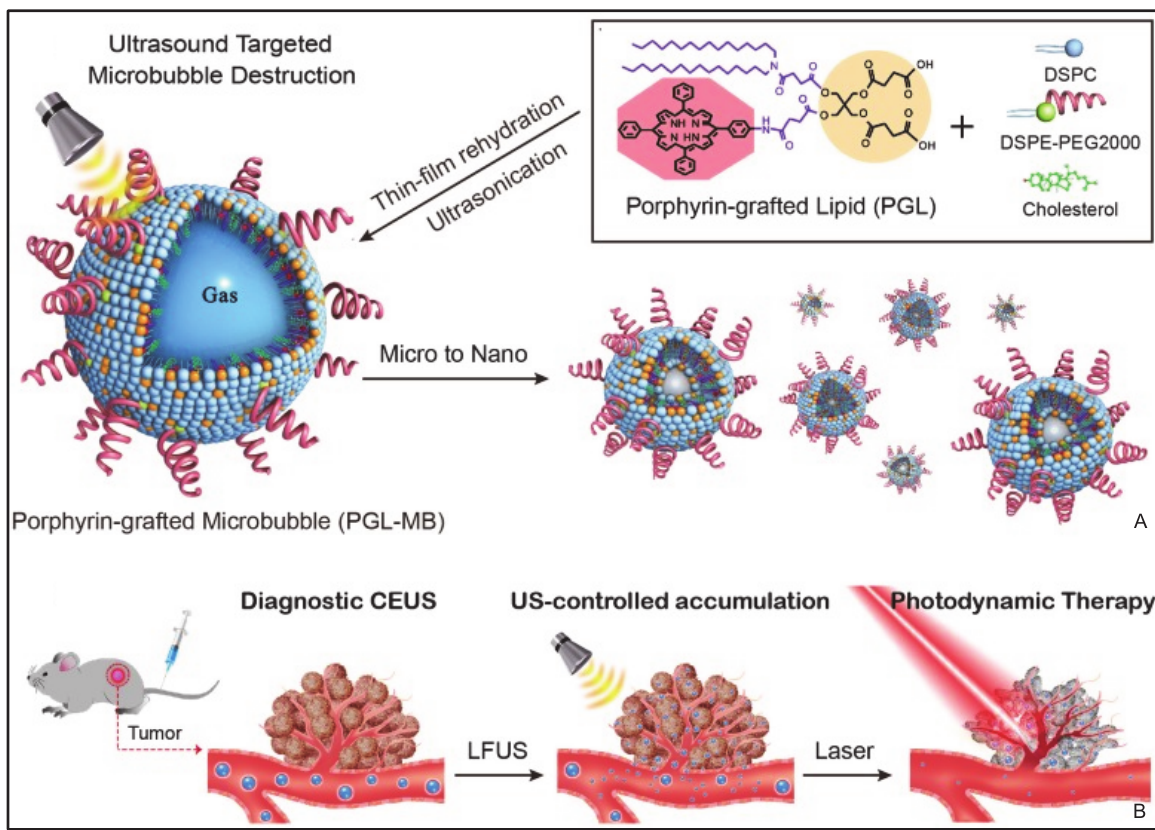
Figure 4 Schematic of the microbubble-based, ultrasound-assisted PDT strategy. (A) Preparation of PGL-MB and its transformation from microbubbles to nanoparticles under exposure to low-frequency ultrasound (LFUS) ; (B) Experimental process of in vivo PDT under the guidance of CEUS imaging, followed by ultrasound targeted microbubble destruction (UTMD). (Reprinted with permission from reference [22])